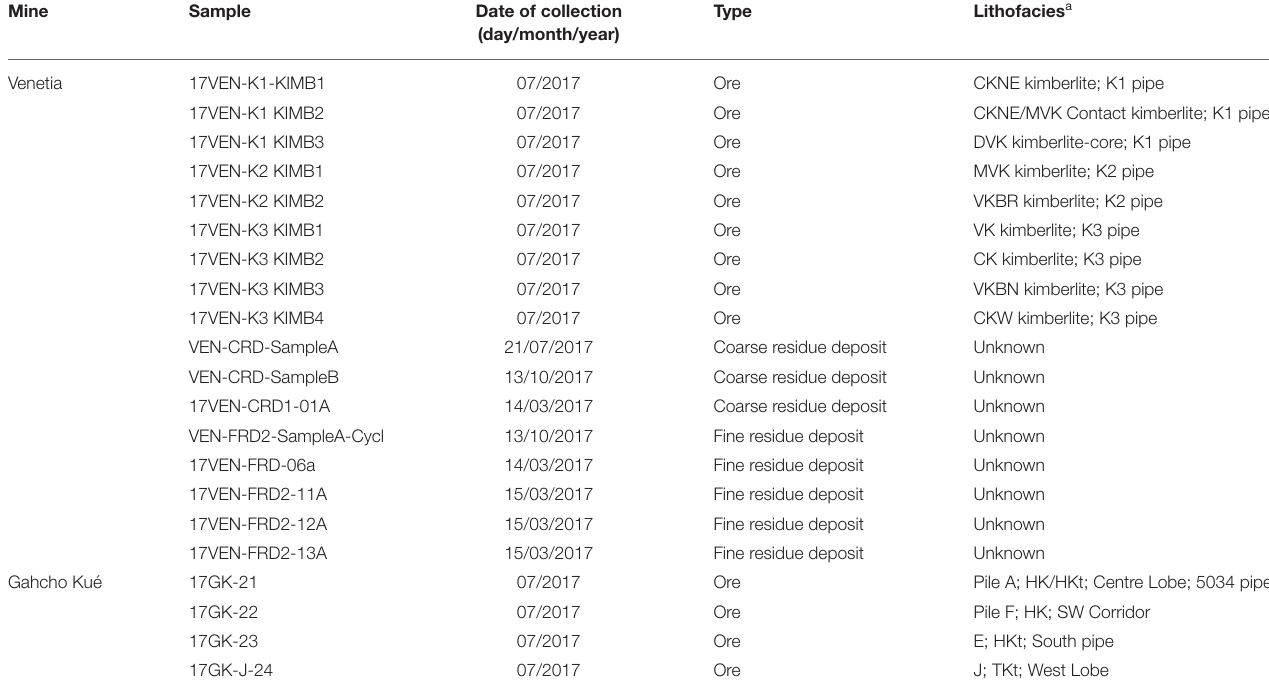
TABLE 1 | Kimberlite facies